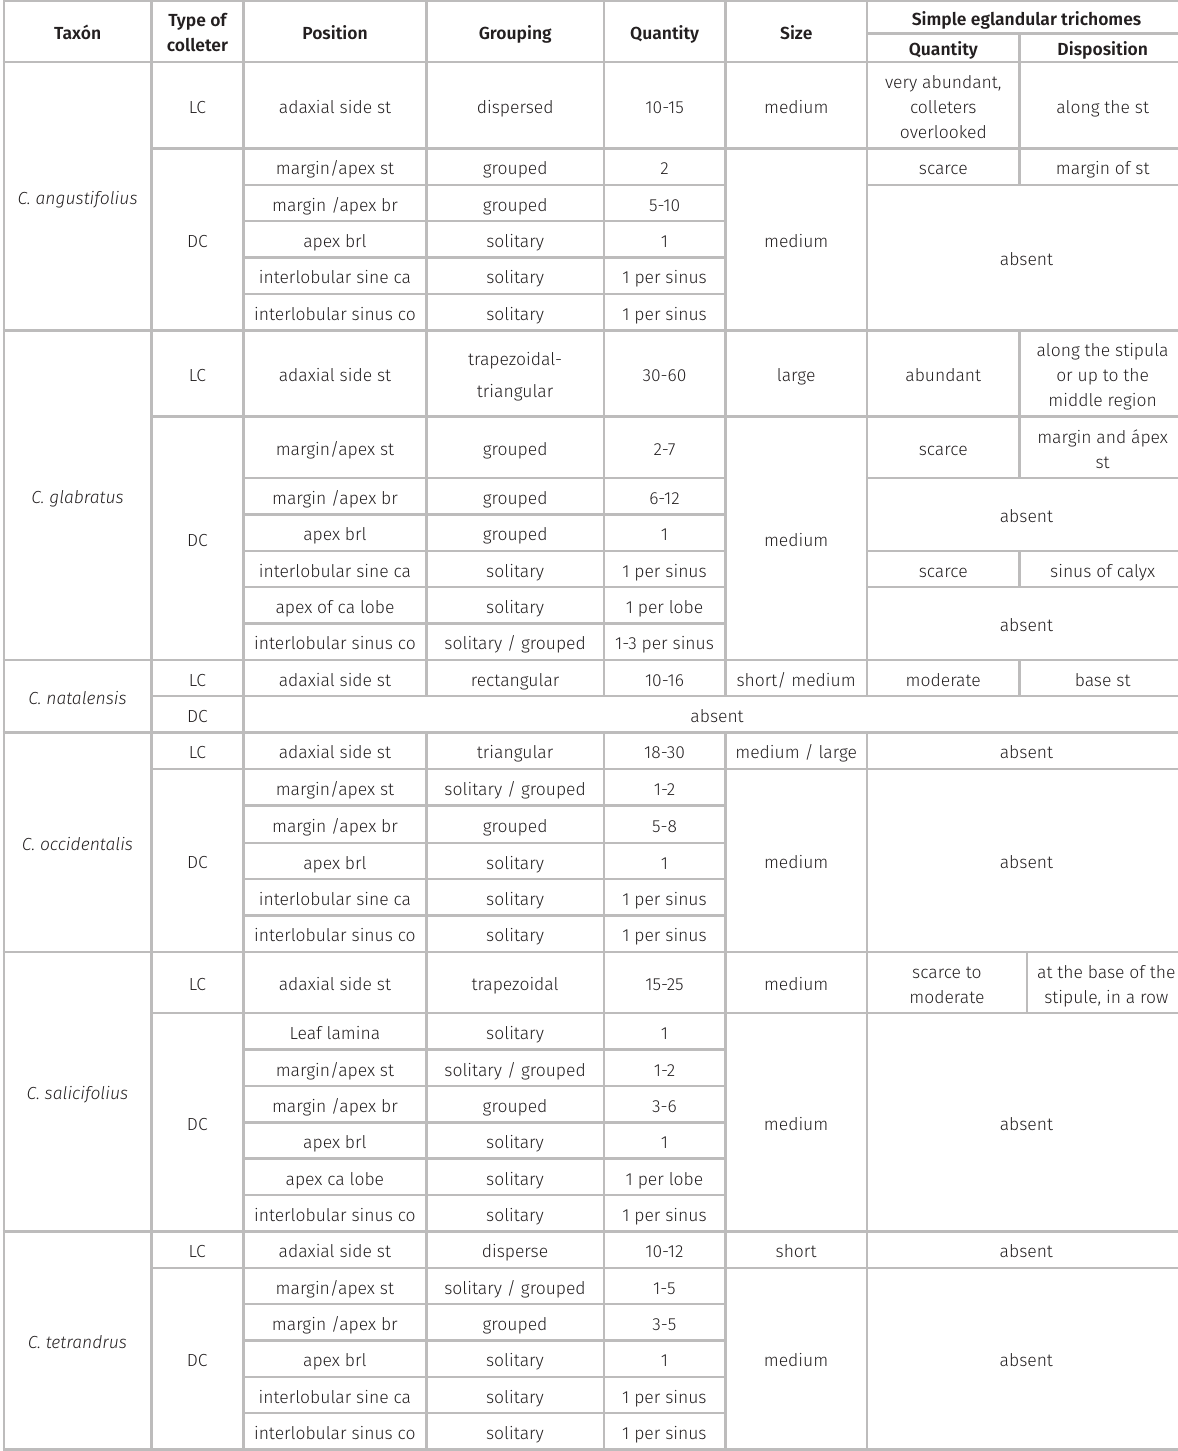
Table II. Characteristics of the light colleters (LC) and dark colleters (DC) colleters and trichomes in Cephalanthus .